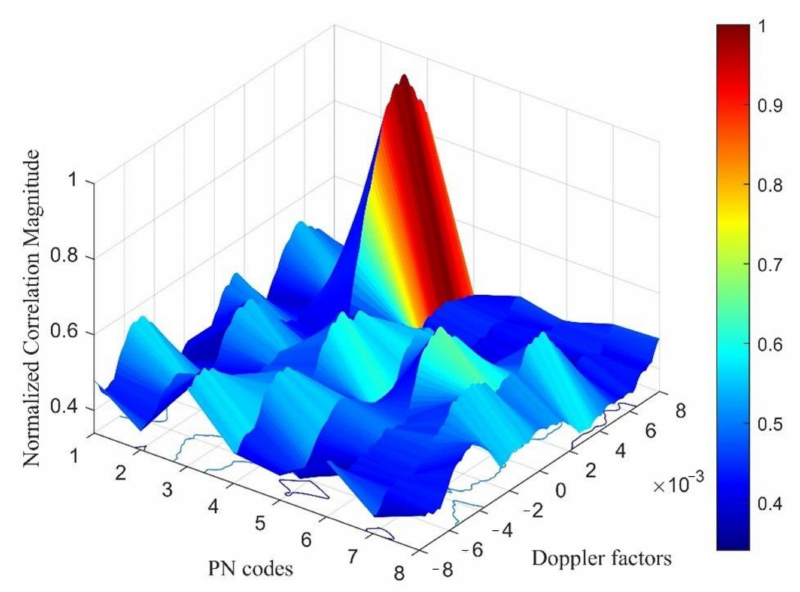
Figure 5. Three-dimensional correlation search